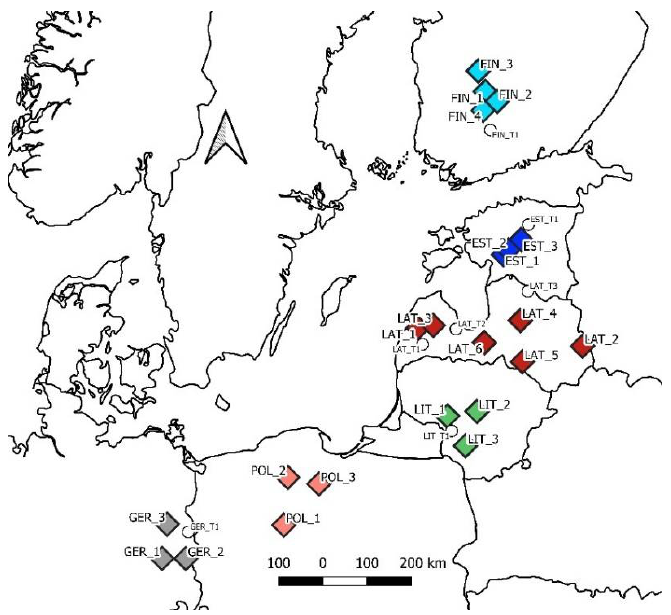
Figure 1. Locations of the sampled stands of Norway spruce used for assessment of linear weather–growth relationships and calibration of model (squares). Circles denote stands used for model verification. Arrow represents geographic north. Table 1. Location, soil type, composition (admixture), and age of the sampled stands of Norway spruce.